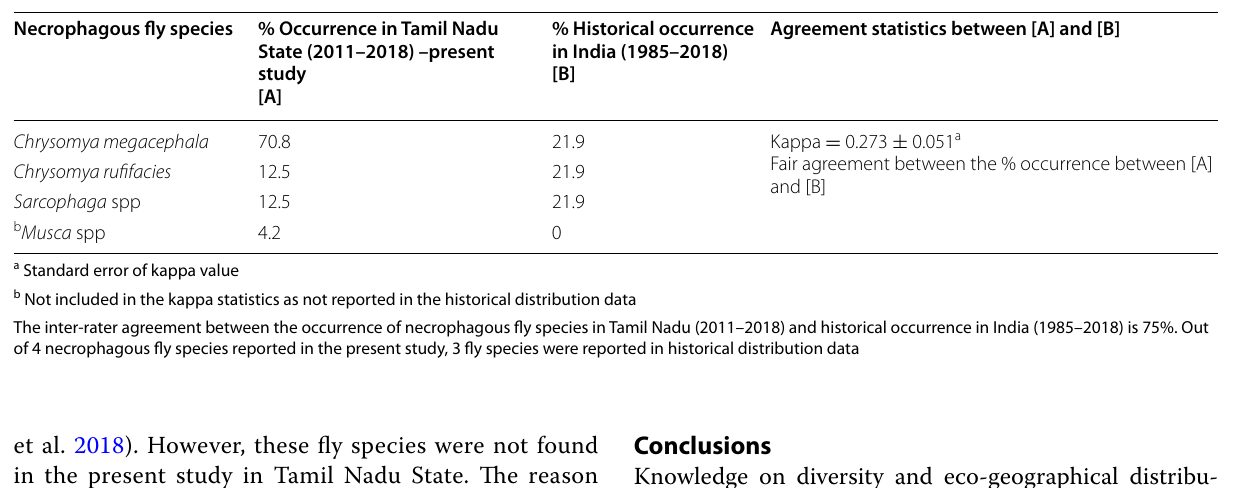
Table 4 Agreement statistics between percentage occurrence of necrophagous fly species in human corpses in Tamil Nadu (2011– 2018) and historical occurrence in India